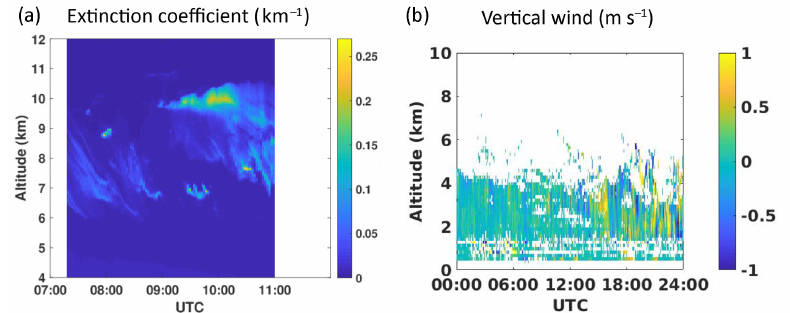
Figure 4. Extinction coefficient in km − 1 derived from IRF lidar (a) and vertical velocity in ms − 1 obtained from ESRAD on 20 February 2013 (b)